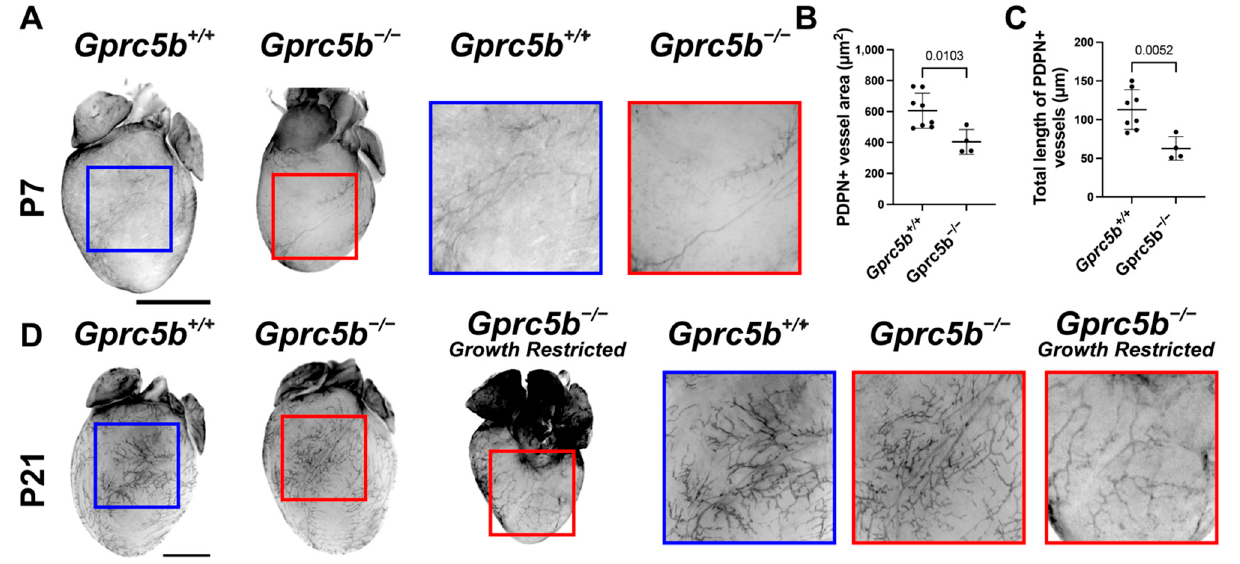
Figure 6. Attenuated postnatal cardiac lymphangiogenesis in developing and growth-restricted Gprc5b − / − mice. ( A ) Whole-mount immunostaining of podoplanin (PDPN)-positive cardiac lymphatics of P7 Gprc5b +/+ hearts (left) and Gprc5b − / − hearts (right). ( B ) Quantification of PDPN-positive vessel area of dorsal or ventral surface of the heart. ( C ) Quantification of total PDPN-positive vessel length of dorsal or ventral surface of the heart. Significance calculated using unpaired t-test. ( D ) Whole-mount immunostaining of podoplanin-positive cardiac lymphatics of P21 Gprc5b +/+ hearts (left), non-growth-restricted (middle) and growth-restricted (right) Gprc5b − / − hearts. High magnification of insets provided to the right of full heart images. Blue border = Gprc5b +/+ , red border = Gprc5b − / − . Scale bar = 2 mm.